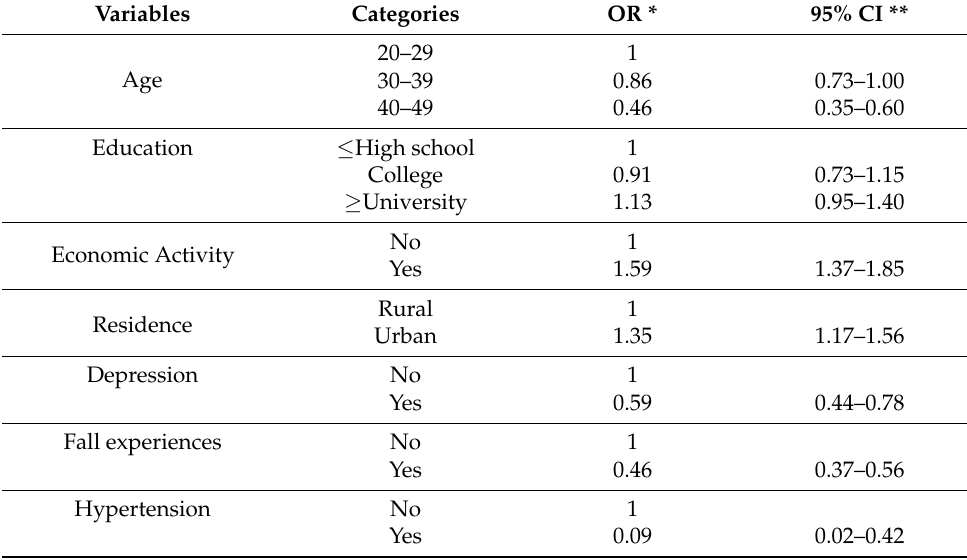
Table 3. Factors affecting the SRH of pregnant